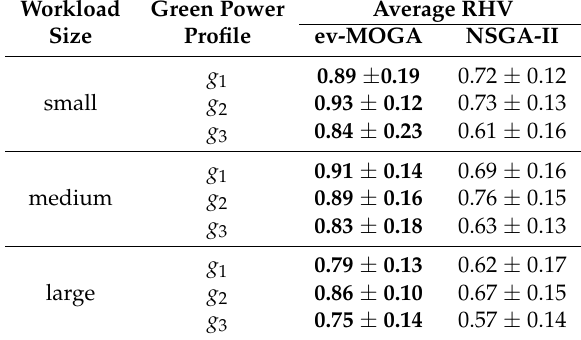
Table 2. Average and standard deviation of the relative hypervolume (RHV) computed by each algorithm for each workload size and green power generation